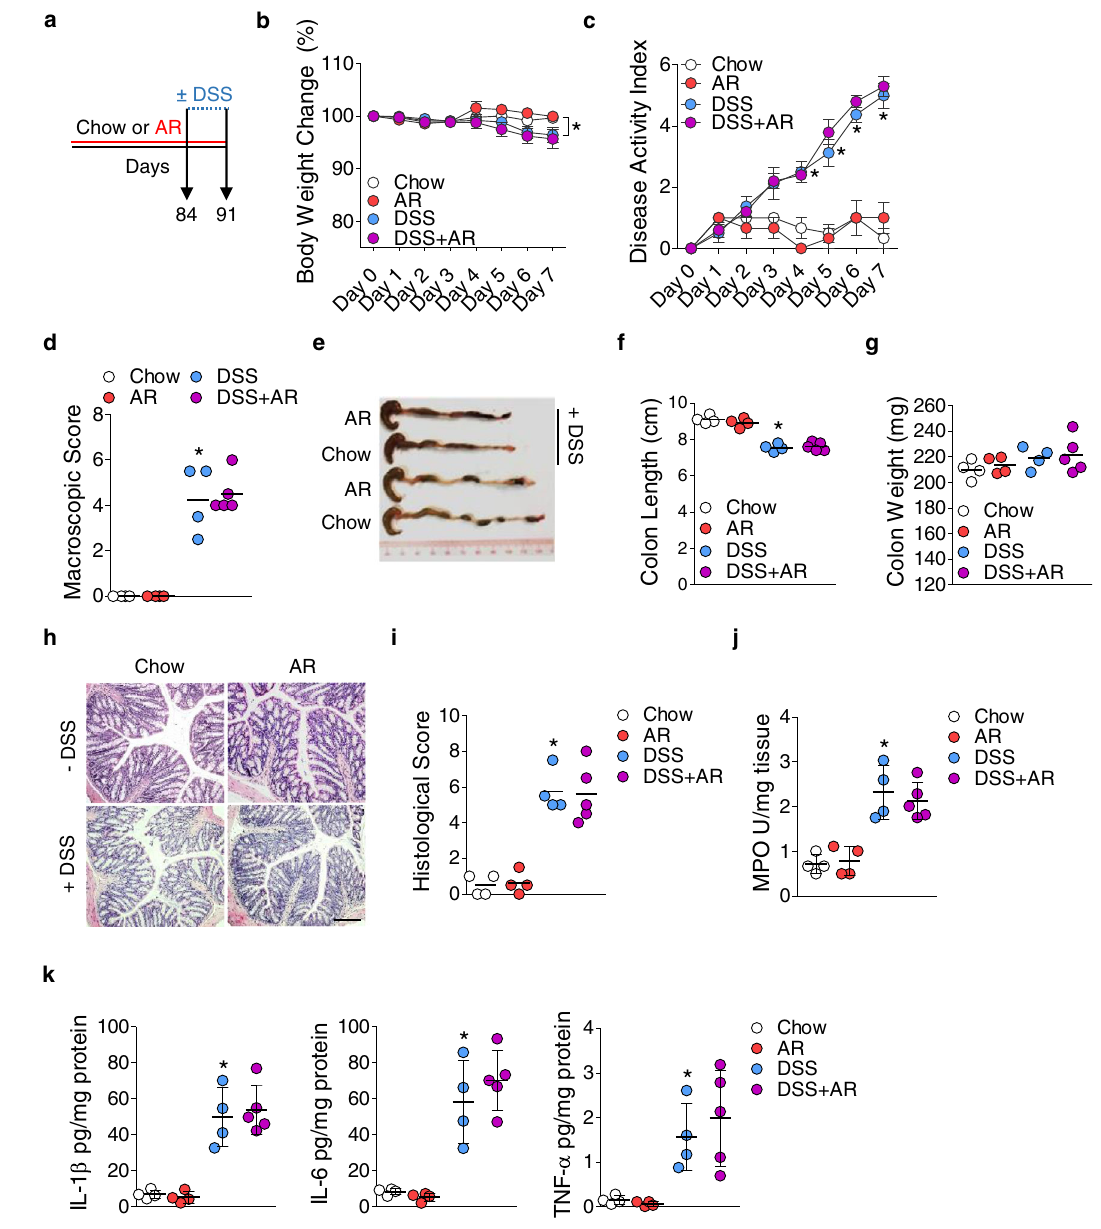
Fig.5|ARdoesnotexacerbatethedevelopmentofDSS-inducedcolitisinTPH1- de fi cient mice. Tph1 − / − mice were either fed normal chow diet or exposed to 100ppmARviadietfor12weeks(84days)priortoinductionofacutecolitisby3.5% DSS for 7 days. During DSS, mice were continuously exposed to AR. a Schematic illustration of the experimental design. b Body weight changes during DSS. c Disease activity index (DAI) during DSS. d Macroscopic score. e A representative imageofcolons. f Colonlength(cm). g Colonweight(mg). h Representativeimages of H&E-stained colon sections on day 7 post DSS; scale bar: 100 µ m. i Histological